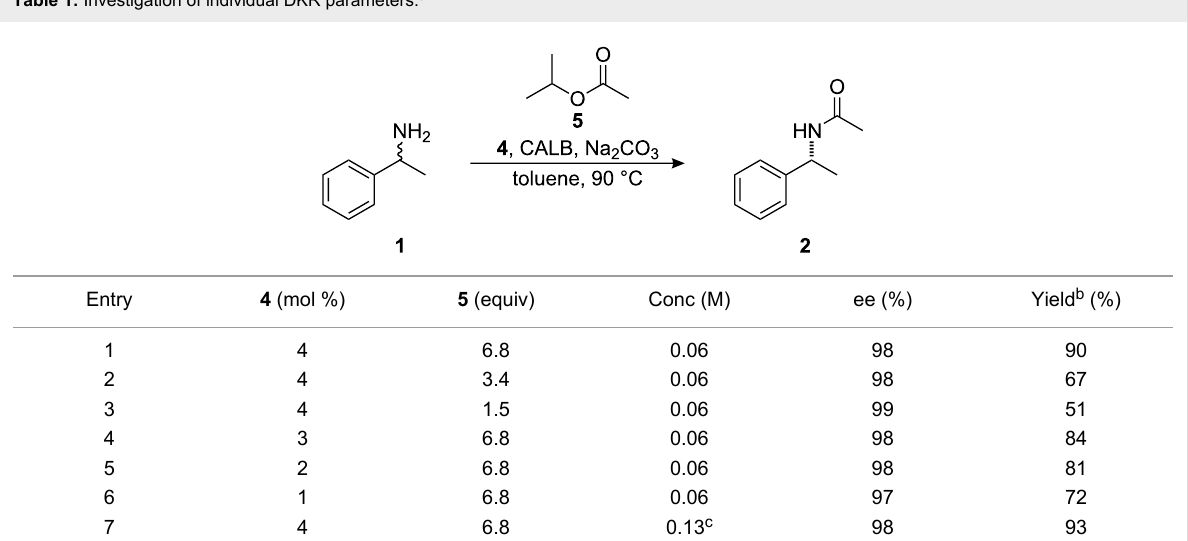
Table 1: Investigation of individual DKR parameters.